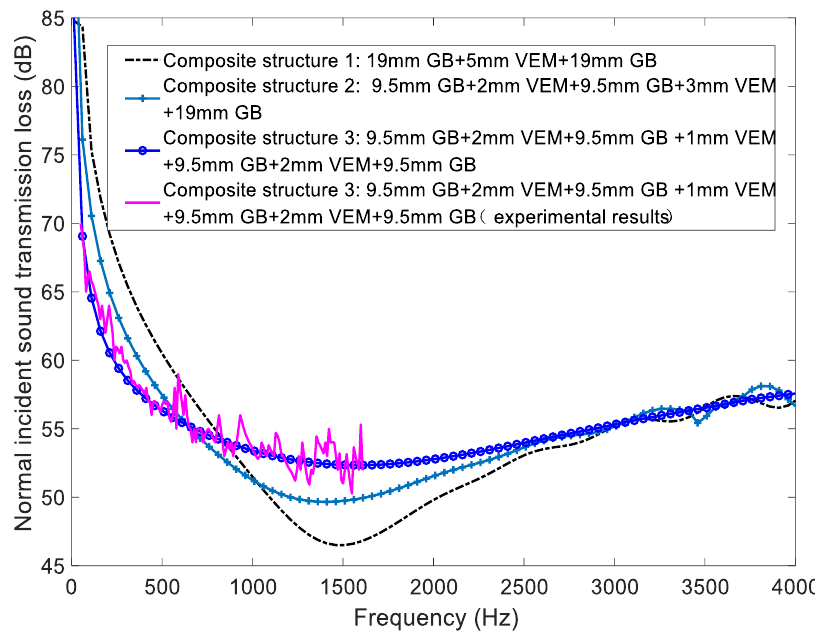
Figure 9. The STL spectrum of the composite partitions with various inter-layers for VEM core and gypsum board.